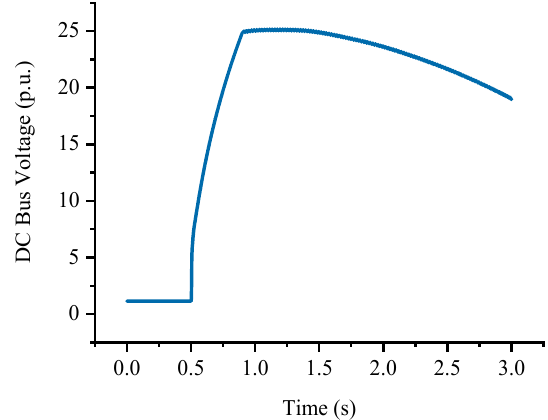
Figure 3. DC bus voltage curve under three-phase short-circuit